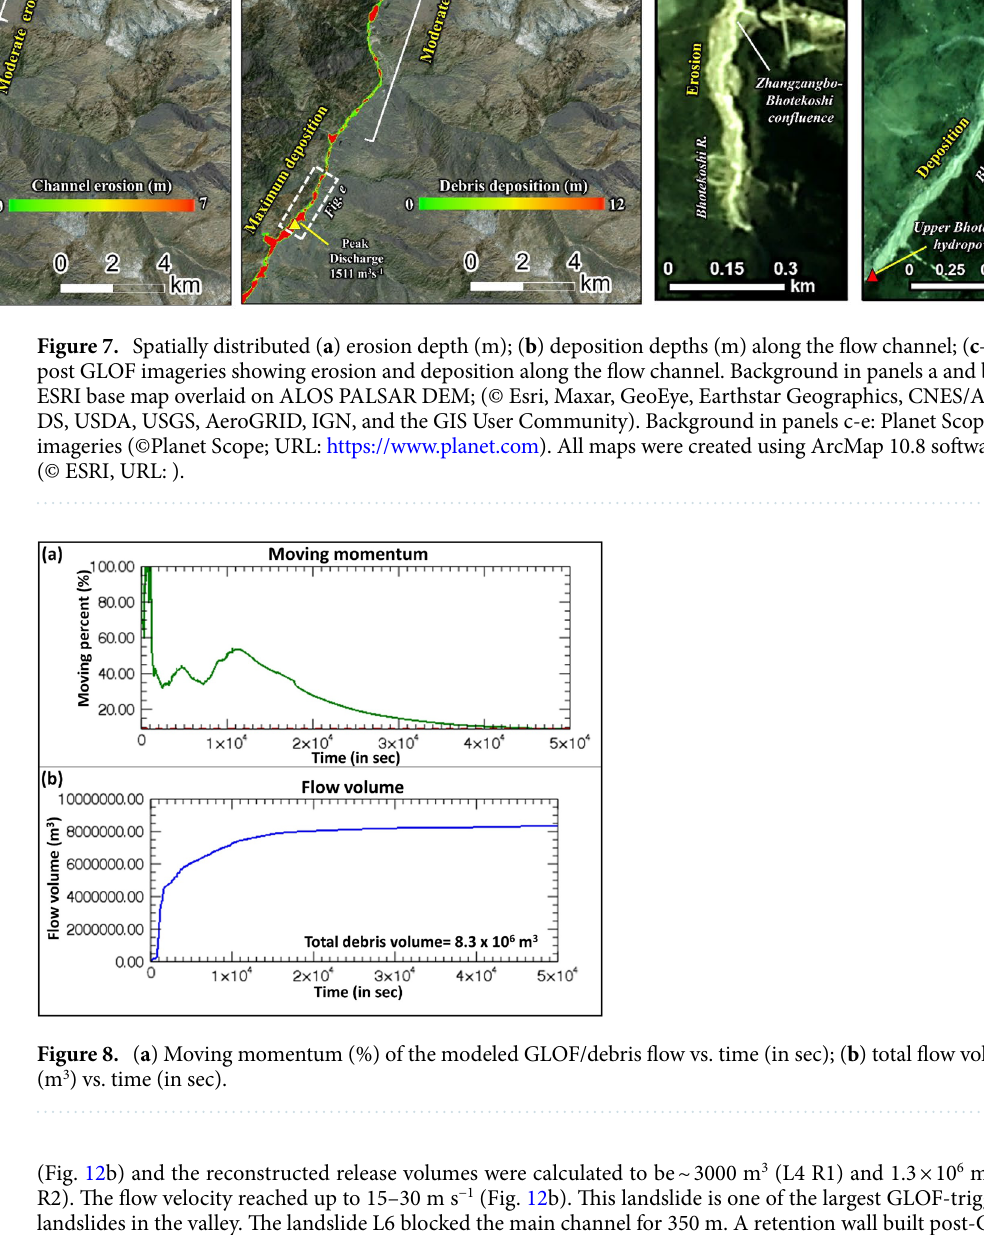
(Fig. 12b) and the reconstructed release volumes were calculated to be ~ 3000 m 3 (L4 R1) and 1.3 × 10 6 m 3 (L4 R2). The flow velocity reached up to 15–30 m s −1 (Fig. 12b). This landslide is one of the largest GLOF-triggered landslides in the valley. The landslide L6 blocked the main channel for 350 m. A retention wall built post-GLOF can be seen along the Bhotekoshi main channel (Figs. 11 and 12c). The reconstructed landslide release volume is calculated to be ~ 4880 m 3 and the volume deposited on the channel is ~ 4610 m 3 . The reconstructed flow depth and velocity reach 6–10 m and 2–3 m s −1 , respectively.